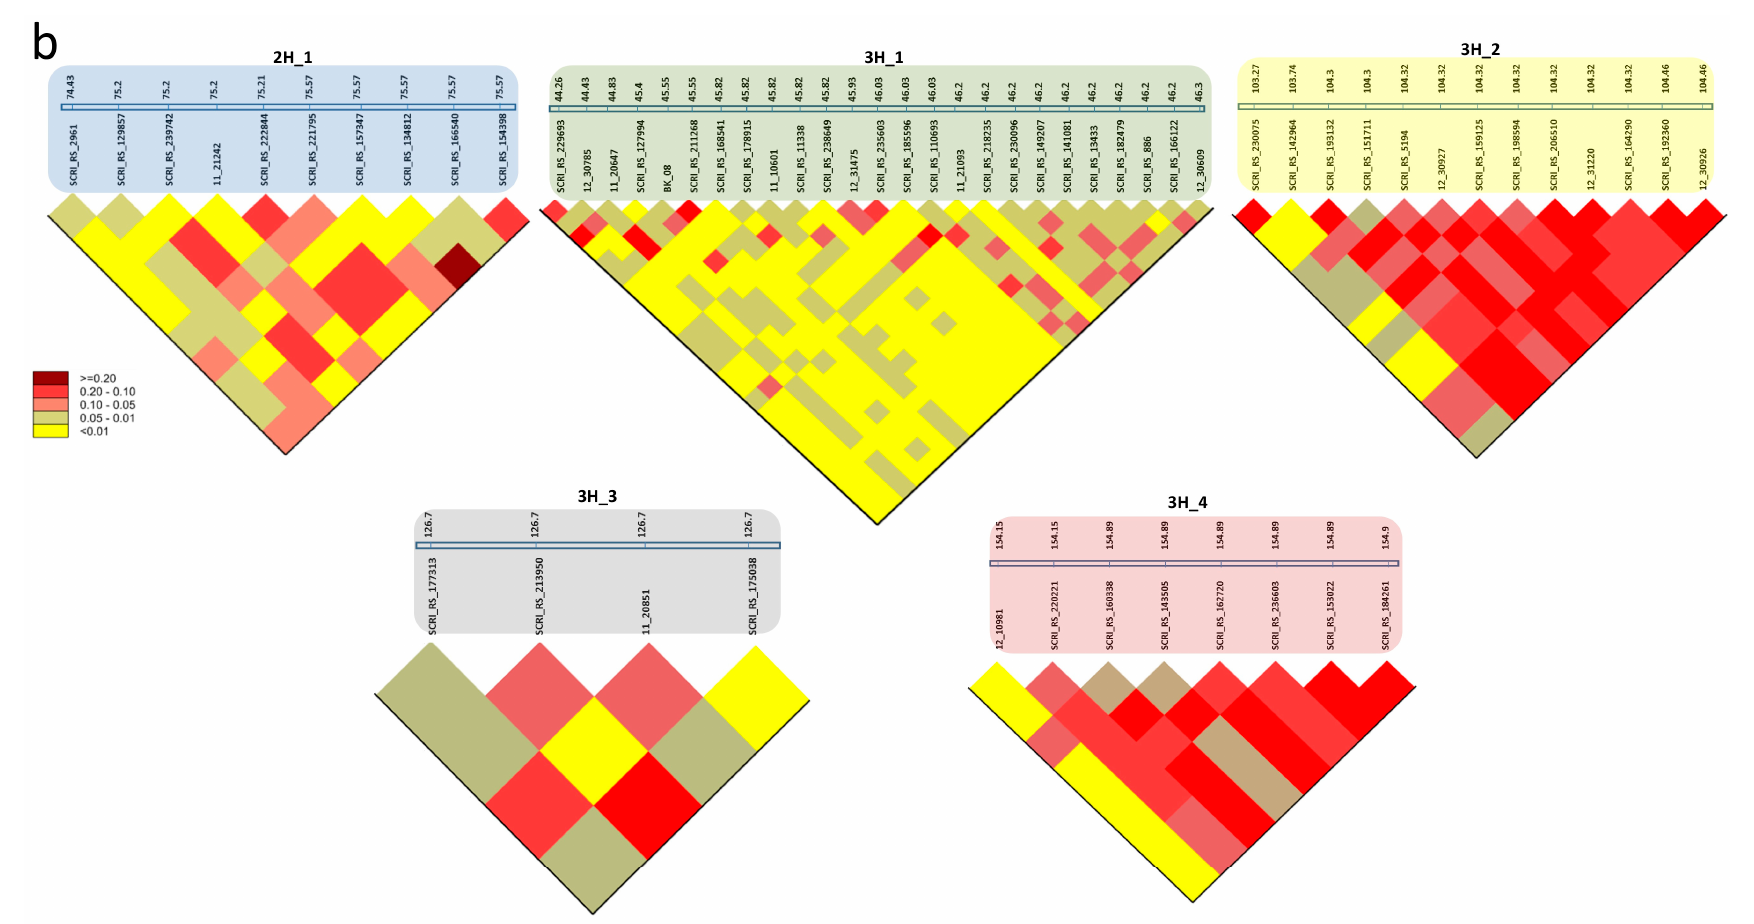
Figure 4. ( a ) The significant SNPs (101 SNPs, − log 10 ≥ 3) associated with all traits under control and drought stress conditions. The x-axis shows the chromosomes and the SNP positions. The y-axis shows the − log 10 ( P -value) for each SNP marker. ( b ) Heatmap linkage disequilibrium to detect the region of candidate genes, which show a consistent effect on traits and associated with SNPs passing ≥ FDR using their physical position.